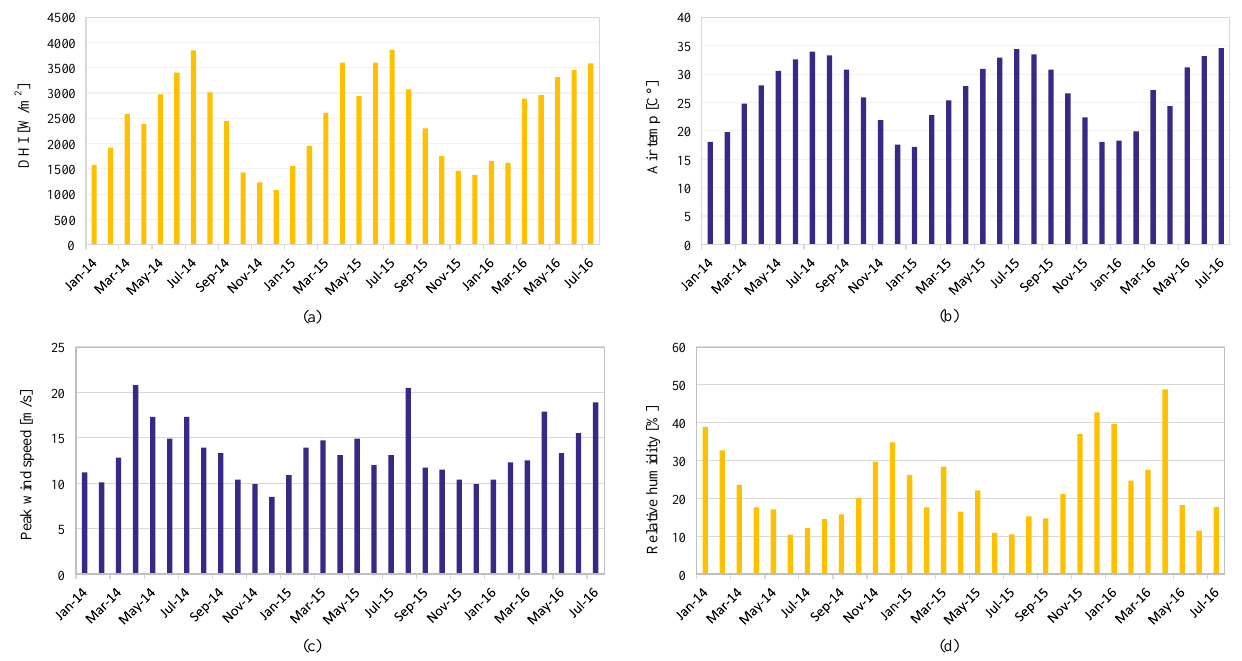
Figure 2. Monthly weather and diffused irradiance data of the Najran university. ( a ) The diffused horizontal irradiance. ( b ) Air temperature. ( c ) Peak wind speed. ( d ) Relative humidity.